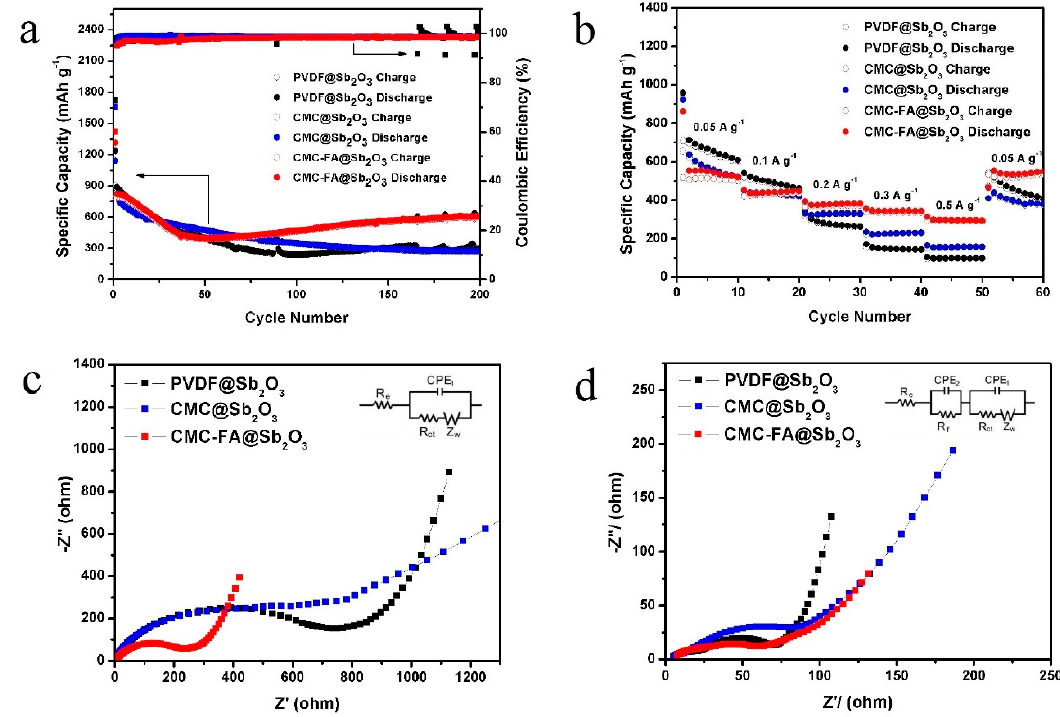
Figure 4. ( a ) Cycling performances of CMC-FA@Sb 2 O 3 , PVDF@Sb 2 O 3 and CMC@Sb 2 O 3 at 0.2 A g − 1 ; ( b ) Rate capabilities of CMC-FA@Sb 2 O 3 , PVDF@Sb 2 O 3 and CMC@Sb 2 O 3 at current density ranging from 0.05 A g − 1 to 0.5 A g − 1 ; Nyquist plots of different electrodes: ( c ) before cycling; ( d ) after 200 cycles at